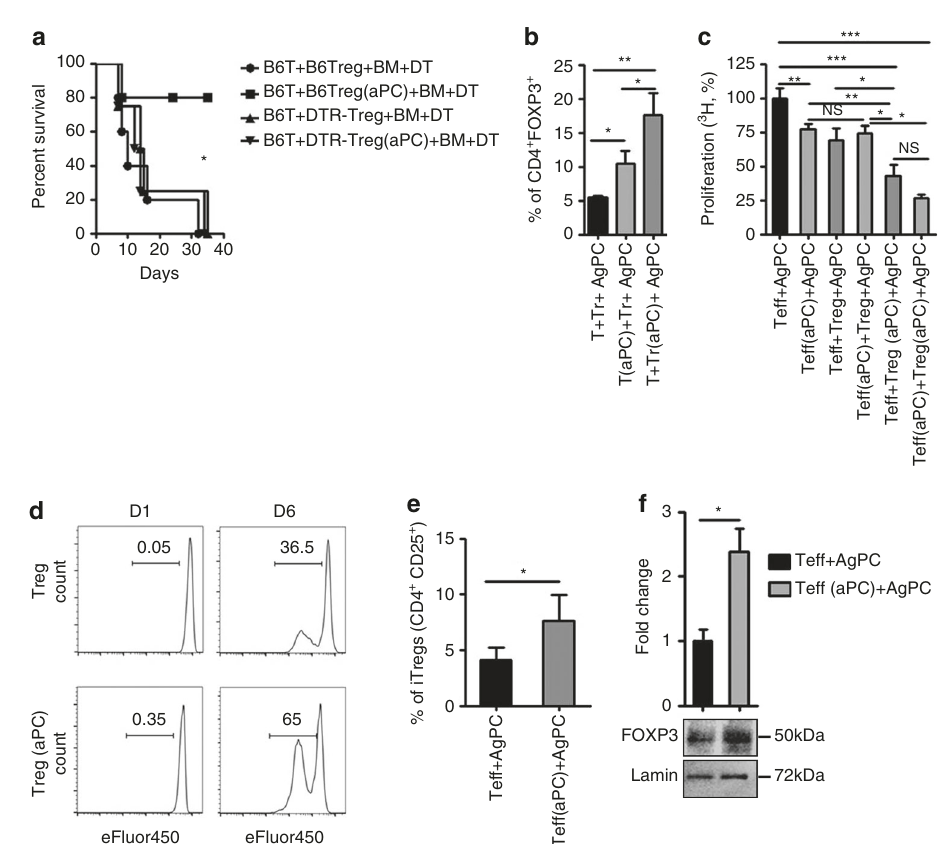
Fig. 5 aPC restricts allogenic T-cell reactivity via regulatory T-cells. a BALB/c mice were irradiated and transplanted with BM (5 × 10 6 ) and T-cells (0.4 × 10 6 ) obtained from C57BL/6 mice and T regs (0.1 × 10 6 ) from C57BL/6 (transgene negative DEREG littermate mice) without (B6T + B6T reg + BM